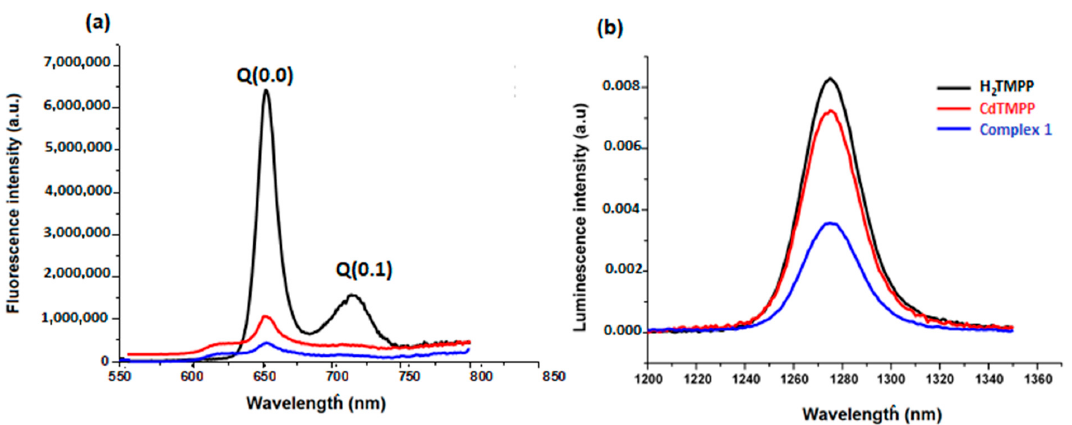
Figure 11. Fluorescence spectra ( a ) and singlet oxygen production spectra ( b ) of H 2 TMPP, [Cd (TMPP)], and [Cd(TMPP)(Pyz)] ( 1 ) at λ ex = 437 nm in CH 2 Cl 2 , c = 10 − 6 M, at 298